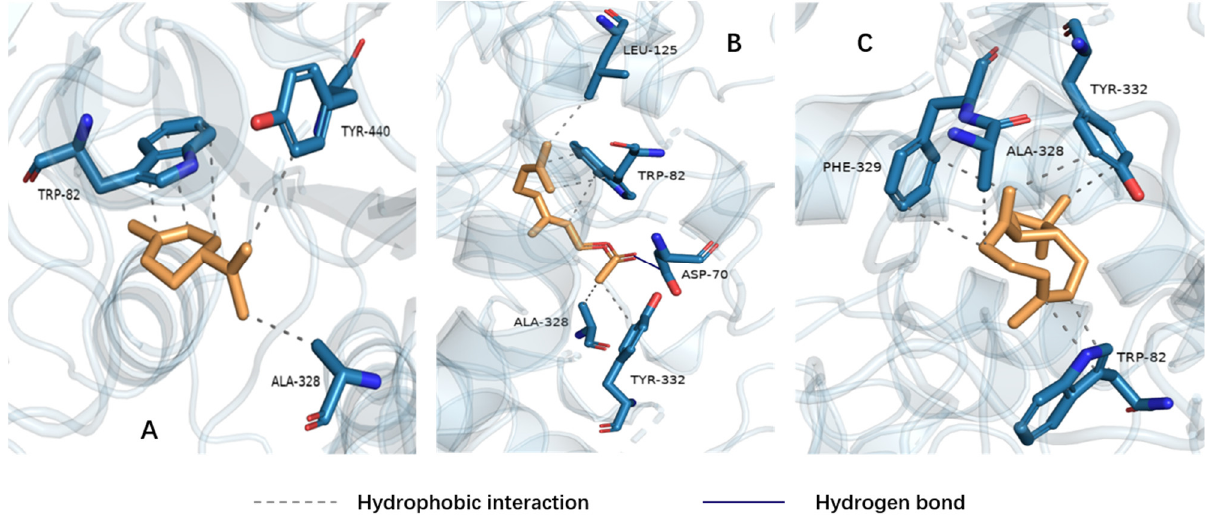
Figure 2. The interactions of butyrylcholinesterase with limonene ( A ), geranyl acetate ( B ) and β-caryophyllene ( C ).